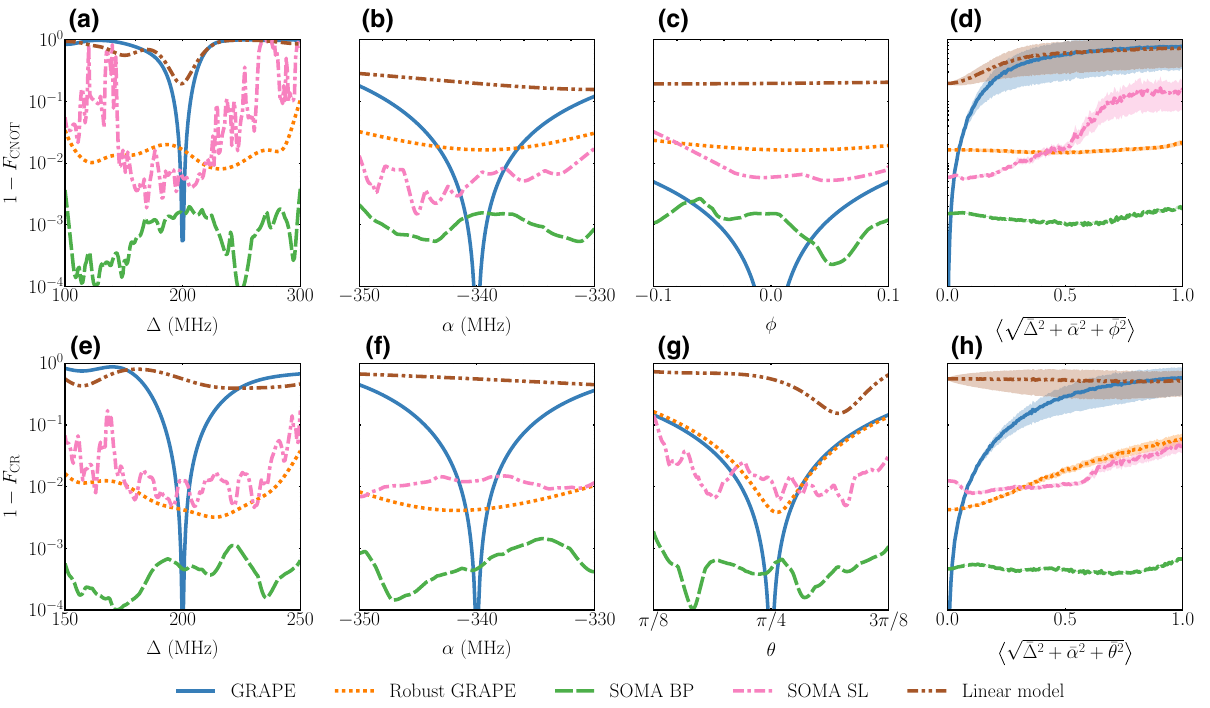
FIG. 6. The infidelity of pulses predicted by the different optimization methods for the direct controlled- NOT ( CNOT ) gate (first row) and the CR (θ) gate (second row) as a function of the different quantum control problem parameters: (a),(e) the frequency difference (cid:7) between the two qubits; (b),(f) the nonlinearity α of the qutrits; (c) the phase error φ between control fields ˆ σ + and ˆ σ − ; and (g) the angle θ parametrizing the CR continuous family of gates given by Eq. (38). (d),(h) The average performance (1000 test samples) of the algorithms as a function of the radial distance from the center (cid:4) λ 0 of the parameter space. The terms ¯ (cid:7) , ¯ α , ¯ φ , and ¯ θ indicate that the problem parameters are renormalized to the space [0, 1] D —see Appendix B. The shaded regions around each plot line show the standard deviation of the corresponding infidelities. A more detailed discussion about the standard deviation can be found in Appendix B. Both gates are optimized with 30 Fourier components for each one of the four control fields and for total gate duration T = 90